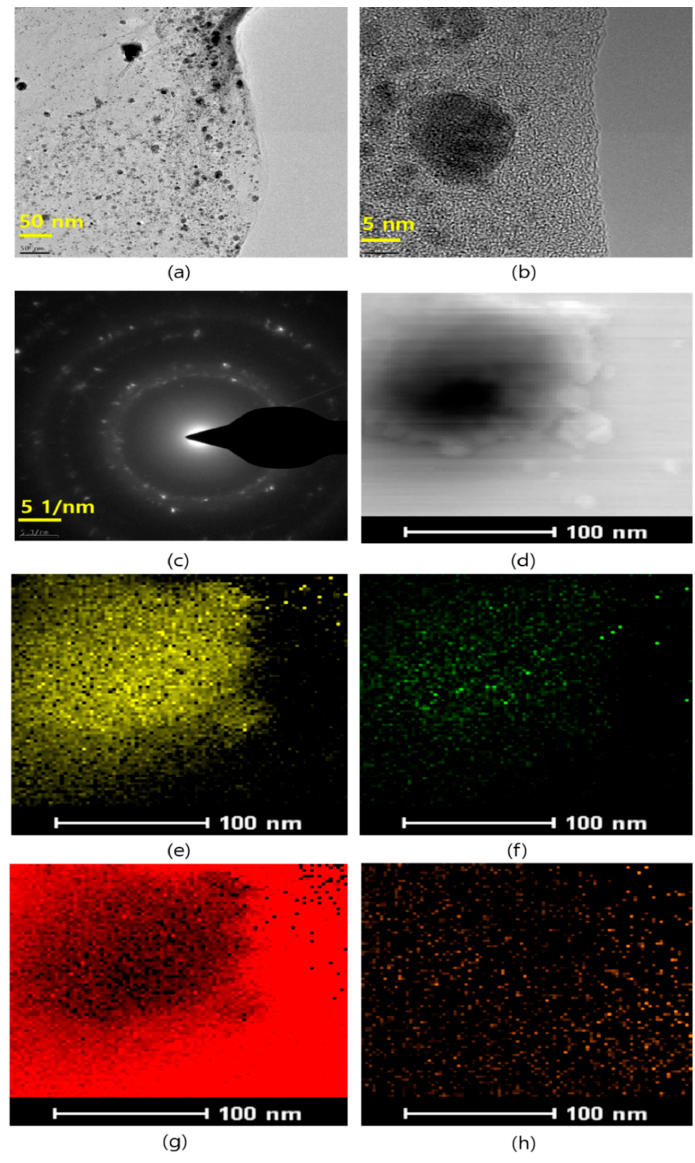
Figure 4. Different magnification TEM images of Pd-Ag nanoparticles anchored on reduced graphene oxide sheets ( a ) 50 nm ( b ) 5 nm ( c ) Selected Area Electron Diffraction (SAED) pattern ( d ) STEM- HAADF image and elemental mapping of ( e ) palladium ( f ) silver, ( g ) carbon and ( h ) oxygen elements presence in Pd-Ag/RGO